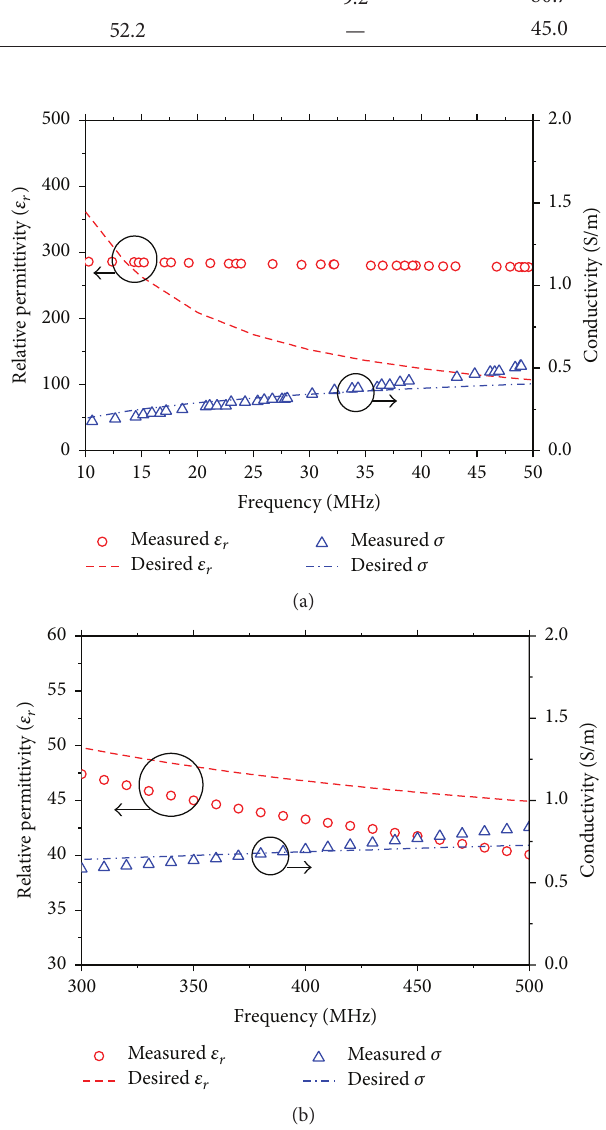
Figure 9: Measured permittivity and conductivity of the developed tissue-emulating materials: (a) for 13.56 MHz and (b) for 402 MHz.